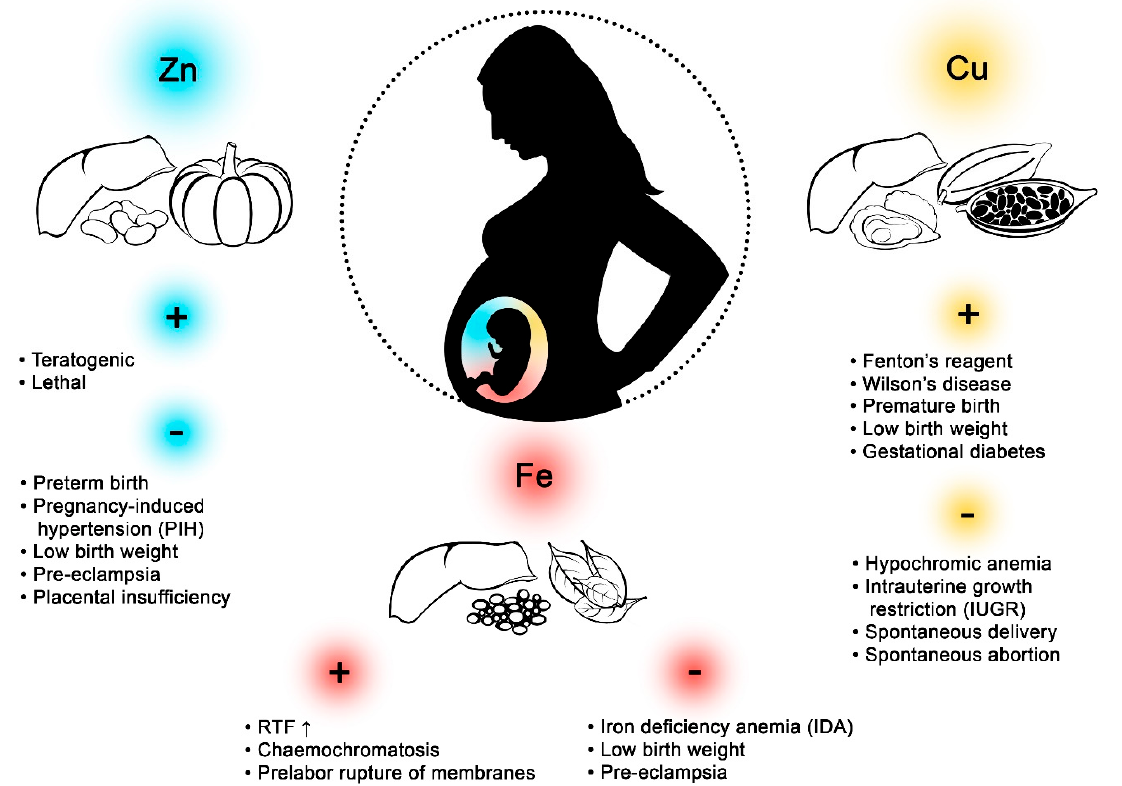
Figure 1. Effects of zinc (Zn), copper (Cu), and iron (Fe) on pregnant women. Excess Zn in the body during pregnancy can have teratogenic or lethal effects. A deficiency of this element may cause preterm birth, pregnancy-induced hypertension (PIH), low birth weight, preeclampsia, and placental insufficiency. High concentrations of Fe in pregnant women may increase the amount of reactive oxygen species (ROS,) lead to hemochromatosis and prelabor rupture of membranes. Fe deficiency, in turn, may lead to iron deficiency anaemia (IDA), low birth weight, and preeclampsia. Hypercupremia may lead to Wilson’s disease and Fenton’s reagent, and may contribute to premature birth, low birth weight, and gestational diabetes. Hypocupremia may lead to hypochromic anemia, intrauterine growth restriction (IUGR), spontaneous delivery, and spontaneous abortion. Large amounts of inorganic Fecan be found in lentils and spinach, while organic Fe is abundant in pork liver. Oysters, beef liver, and cocoa are rich sources of Cu, while calf liver, pumpkin, pork liver, and white beans have high concentrations of Zn.